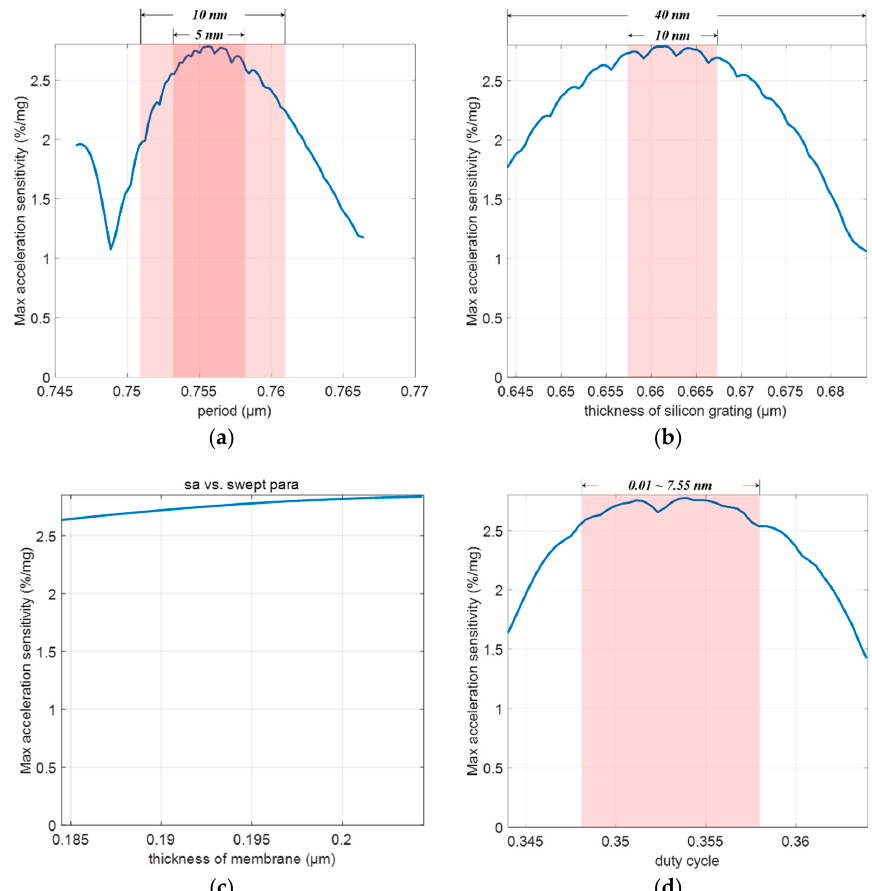
Figure 15. Maximum acceleration measurement sensitivity as a function of: ( a ) The period of silicon grating, with sensitivity being higher than 2%/m g with a tolerance of 10 nm; ( b ) the thickness of silicon grating, with sensitivity that can be higher than 2%/m g with a tolerance of 20 nm; ( c ) the film thickness, which has little impact on the sensitivity; and ( d ) the duty cycle, where the sensitivity can be higher than 2.5%/m g with a tolerance of 0.01.